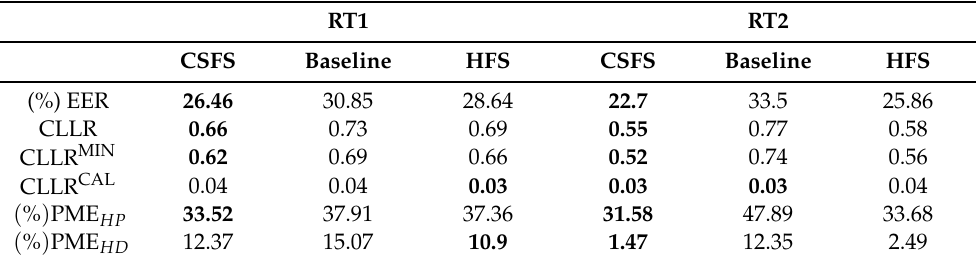
Table 4. Summary of the results for accuracy, discriminating power and calibration for the stabilized videos. The best performance is highlighted in